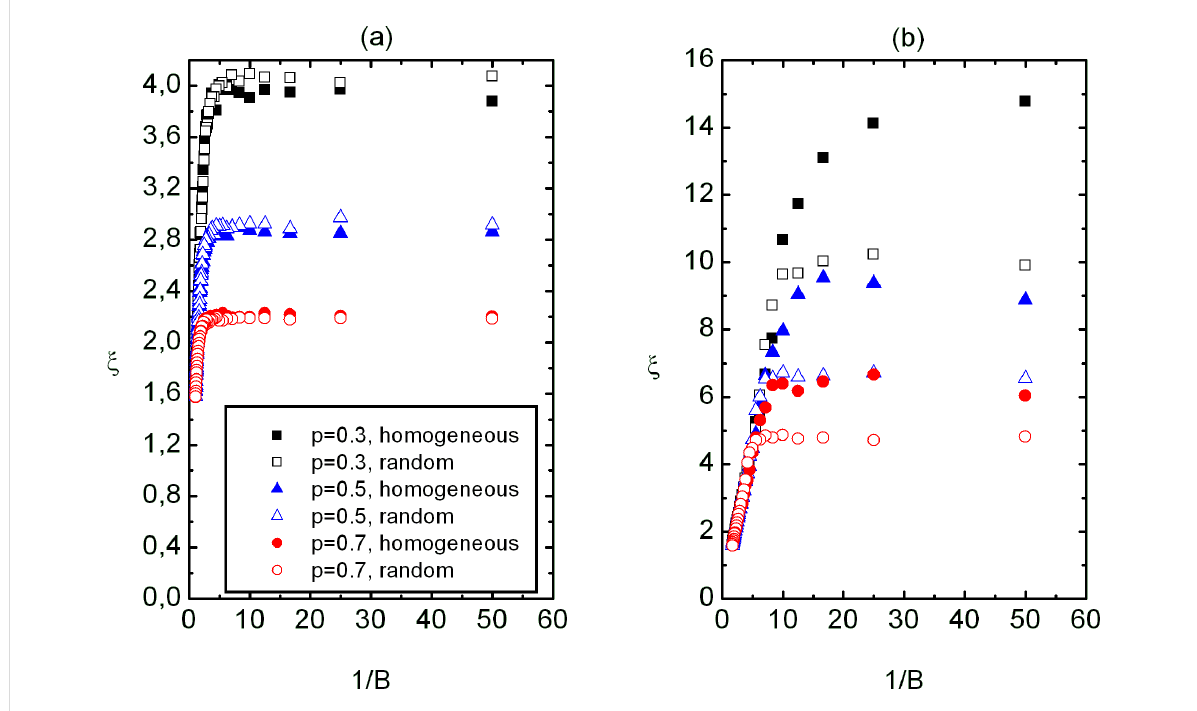
Figure 2: Correlation length ξ as a function of 1/ B for homogeneous and random samples for three different concentrations of impurities in (a) 2D and (b) 3D. The ξ B ( B ) dependence displays a crossover between the disordered and ordered regime. The disordered regimes extends at ( B < B c ), where ξ (hom) > ξ (ran) . In the ordered regime ( B > B c ) one observes ξ (ran) ≈ ξ (hom) ≈ ξ B . (a) W = 2.5, N 0 = 260; (b) W = 2.5, N 0 = 100. The legend is shown in (a).